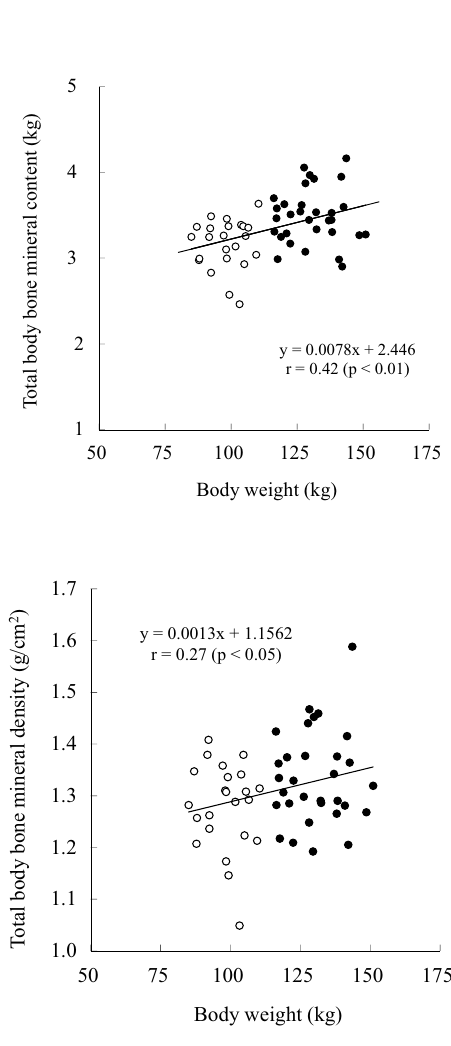
Figure 1. Relationships of body weight with total body bone mineral contents and density. ○ : middleweight Sumo wrestlers, ● : heavyweight Sumo